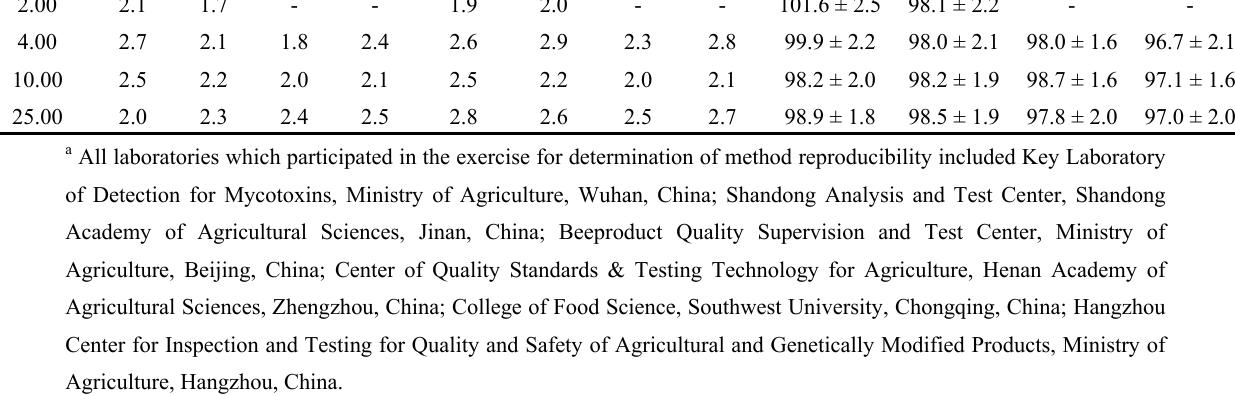
, AFB , AFG , AFG standard 1 2 1 2